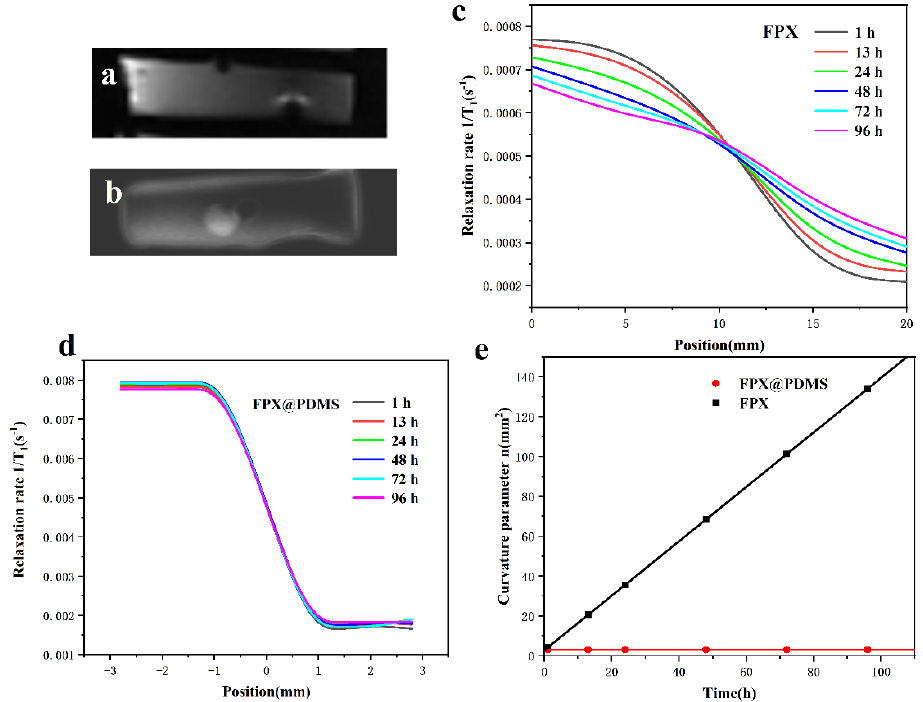
Figure 9. ( a ) MR image of conventional FPX dosimeter used to study the Fe 3+ diffusion. ( b ) MR image of core-shell FPX@PDMS dosimeter used to study the Fe 3+ diffusion. ( c ) Relaxation rates of the FPX dosimeter at different positions as a function of time after irradiation. ( d ) Relaxation rates of the FPX@PDMS dosimeter at different positions as a function of time after irradiation. ( e ) Comparisons of linear fittings of curvature parameter to time after irradiation in FPX dosimeter and FPX@PDMS dosimeter.